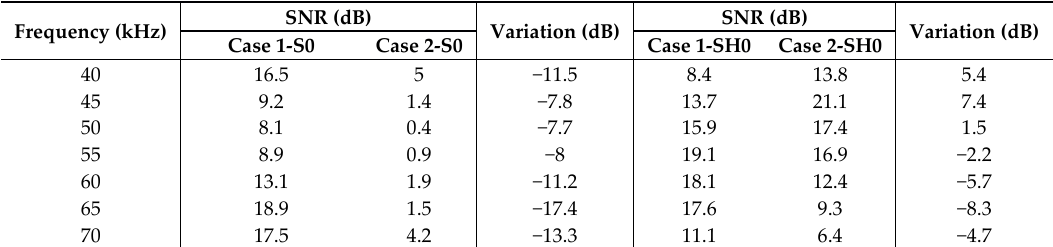
Table 3. Experimental SNR of the mode of interest for both cases for a range of frequencies.